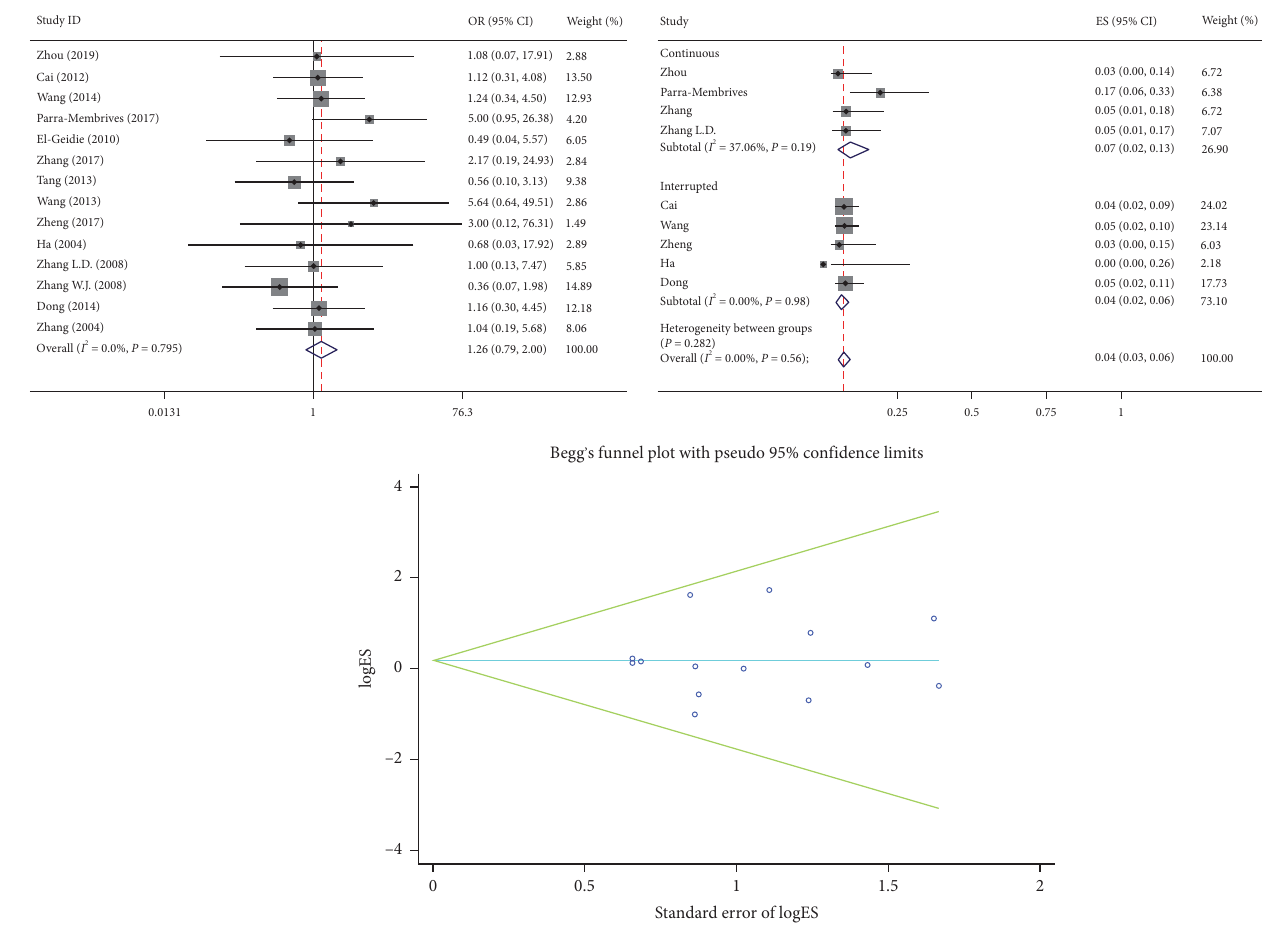
F IGURE 8: Forest plot of meta-analysis and single-arm meta-analysis and funnel plot of the bile leakage between the primary suture group and the T-tube drainage